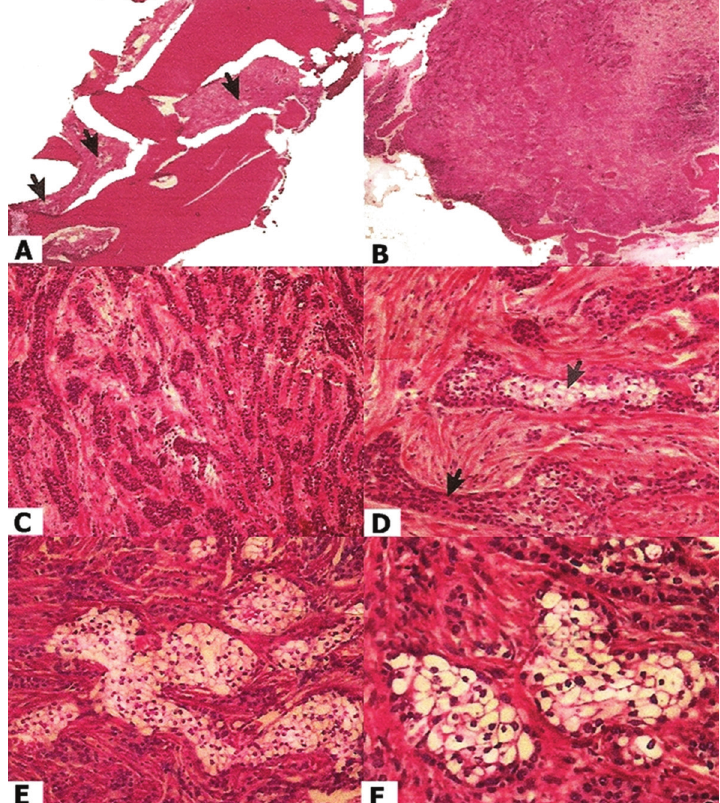
Figure 3- Histological features – (A, B and C) Lesion with a trabecular pattern, with moderate desmoplasia, without necrosis, showing infiltration into the trabecular spaces of the bone tissue (black arrows). (D, E and F) Presence of clear cells (black arrows) confirming tumoral trabeculae into mandible